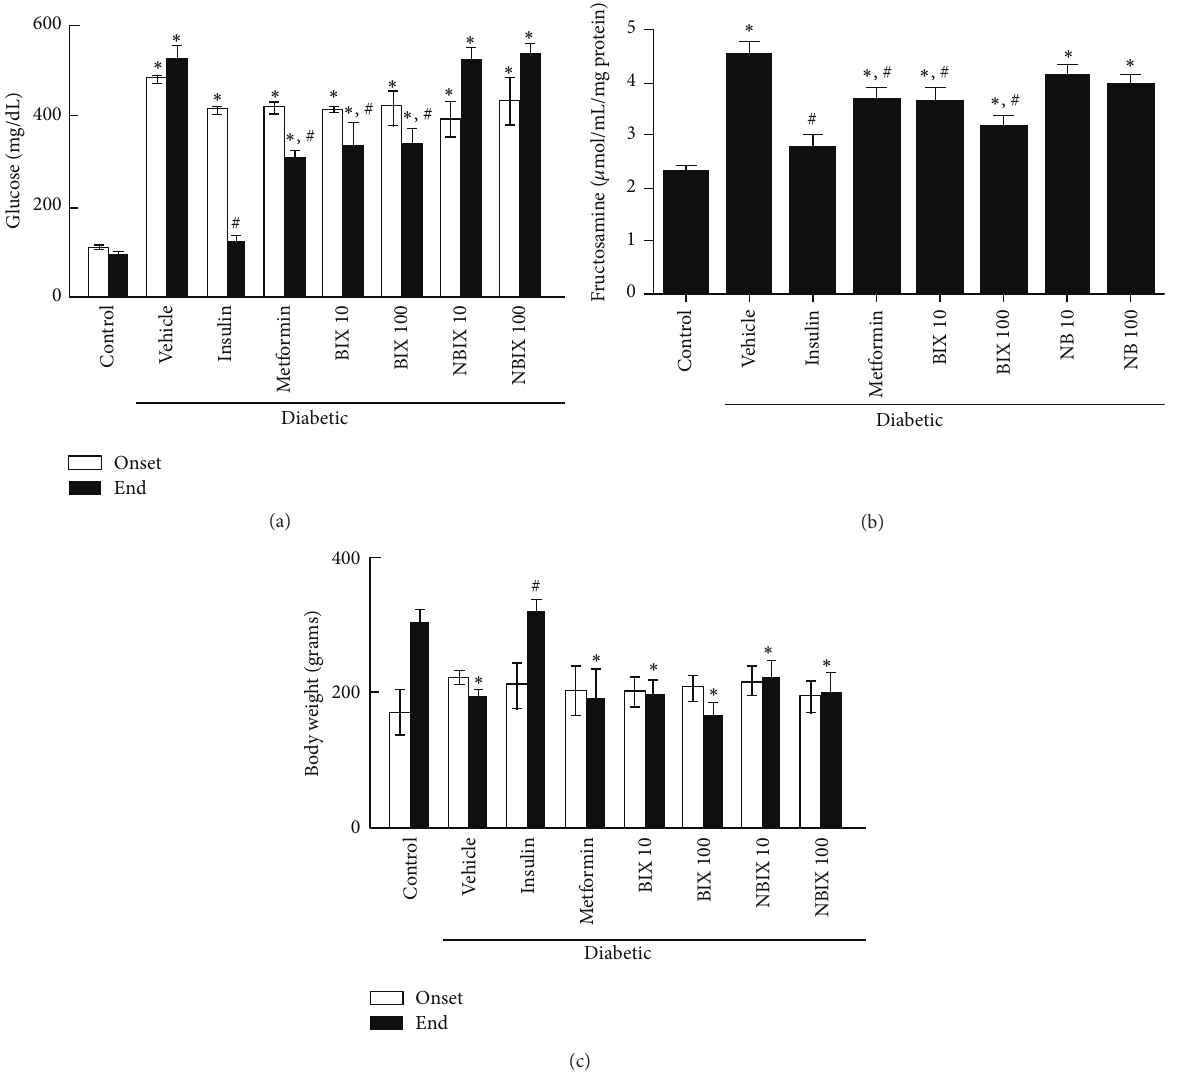
Figure 2: Blood glucose (a) and fructosamine levels (b) and body weight (c) of streptozotocin-induced diabetic rats. Blood glucose levels and body weight were assessed at the onset and end of treatment with vehicle, bixin, norbixin, insulin, or metformin. Fructosamine levels were assessed at the end of the treatment. Data are expressed as means ± SEM ( 𝑛 = 6 per group). ANOVA followed by Duncan’s test: ∗ 𝑃 < 0.05 versus the respective nondiabetic control; # 𝑃 < 0.05 versus the respective diabetic vehicle. BIX 10:10mg/kg bixin; BIX 100:100 mg/kg bixin; NBIX 10:10mg/kg norbixin; NBIX 100:100 mg/kg